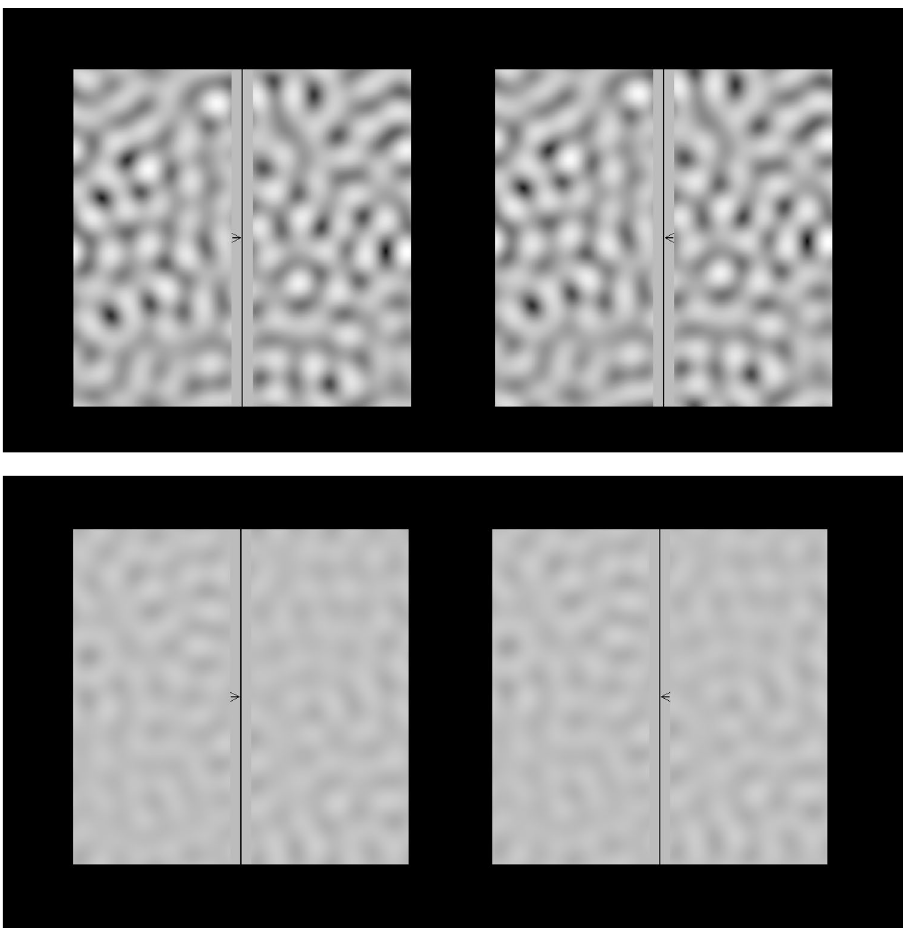
Figure 6. Examples of the stimuli, a high contrast (top) and a low contrast (bottom) one octave bandwidth noise pattern. The arrow heads on each sides of the central vertical lines are the nonius lines. Free fusing the two images makes it possible to appreciate the nonius